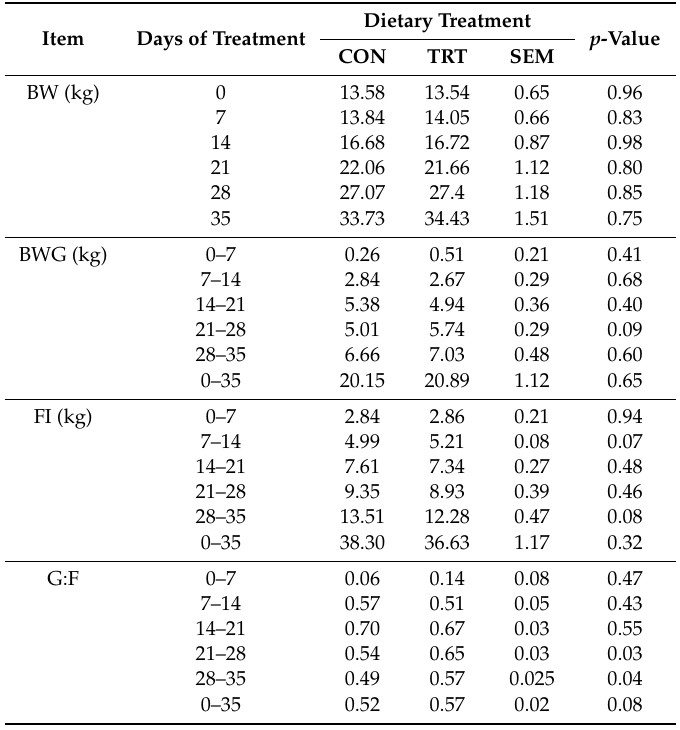
Table 2. E ff ects of mannan oligosaccharides supplementation on growth performance of postweaning piglets. Data are shown per pen as LSMeans ± SEM. Dietary Item Days of Treatment